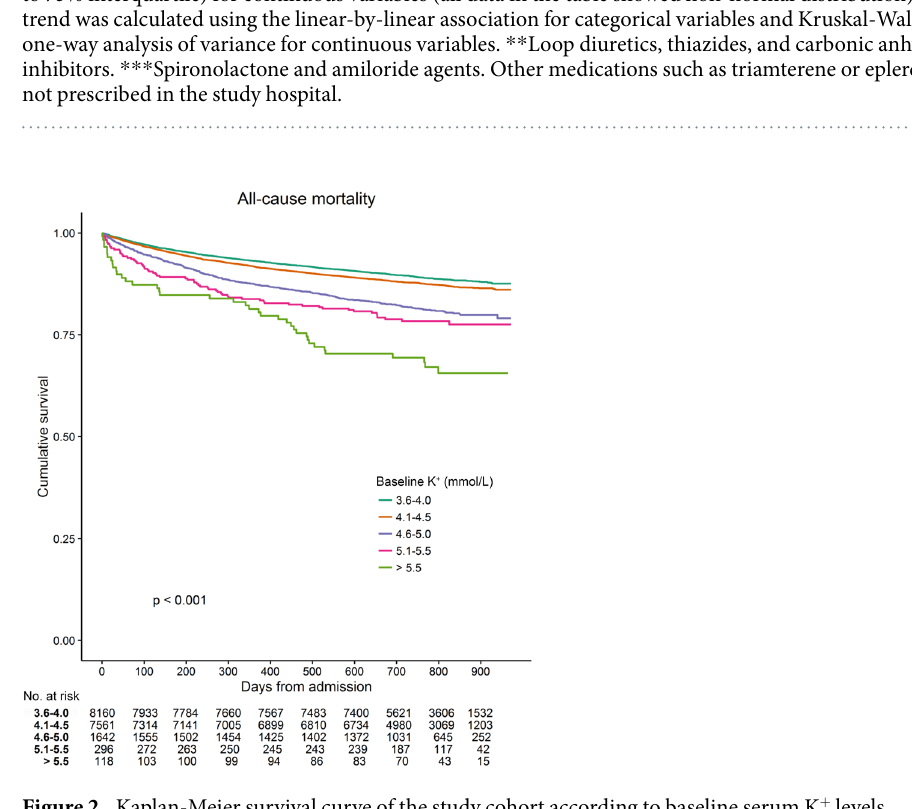
Figure 2. Kaplan-Meier survival curve of the study cohort according to baseline serum K +